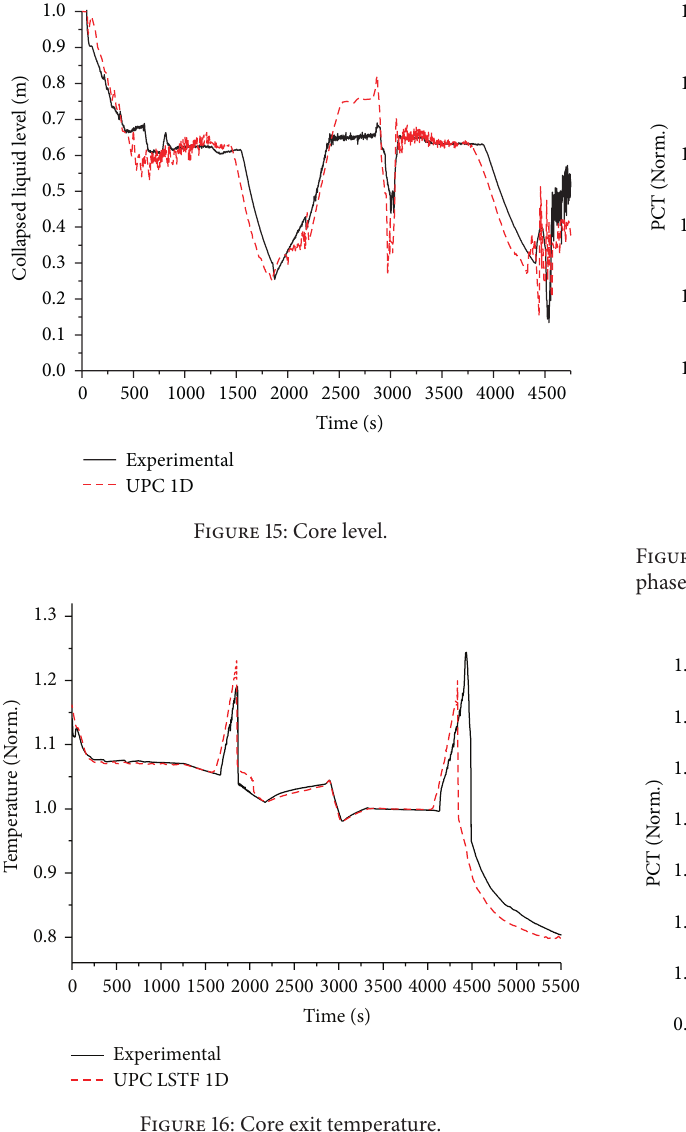
Figure 16: Core exit temperature.